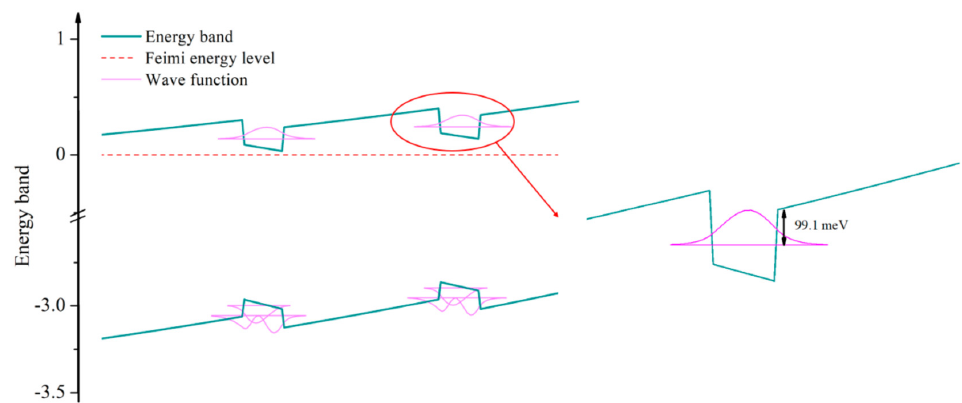
Figure 11. The calculated energy band structure via simulation software